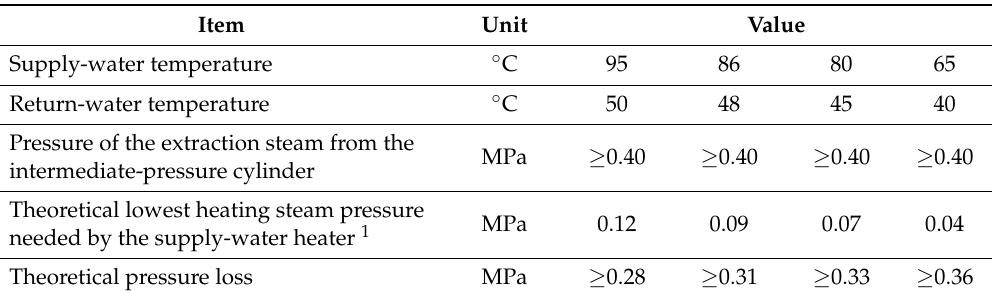
Table 2. Theoretical pressure loss during the actual heating process under different supply and return-water temperatures.